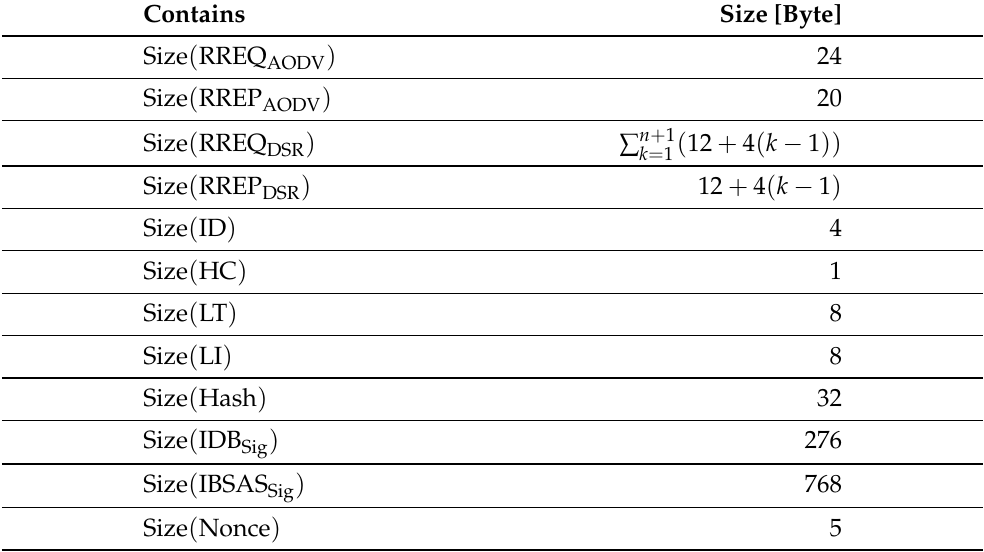
Table 1. Parameters for performance